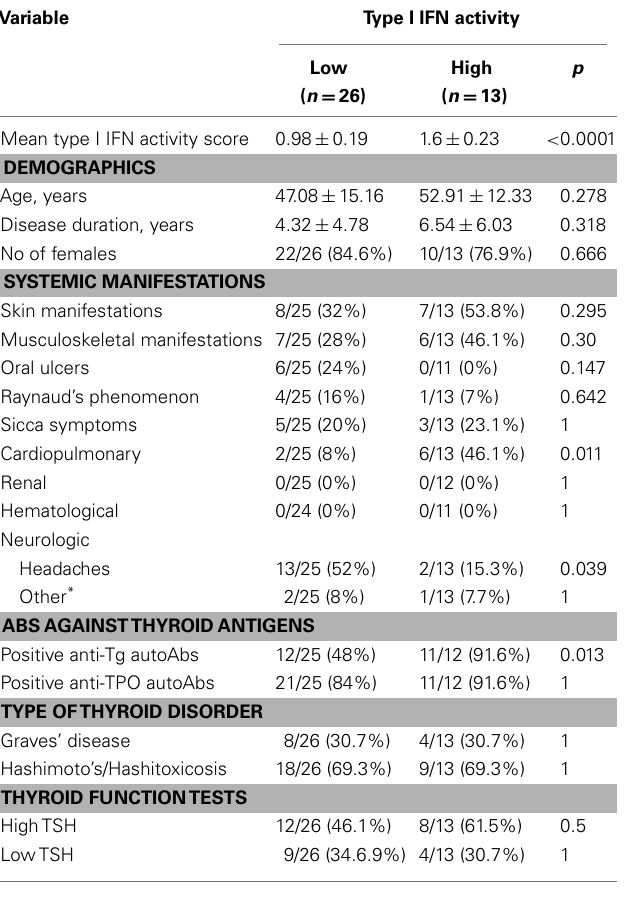
Table 2 | Comparison ofATD patients with low or high type I IFN activity in bivariate analysis.